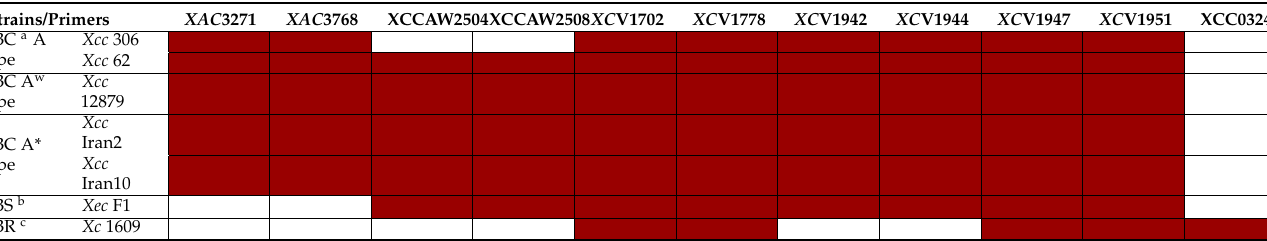
Table 5. PCR amplification of some xanthomonads’ MCPs using primers previously described [19] and those designed in this